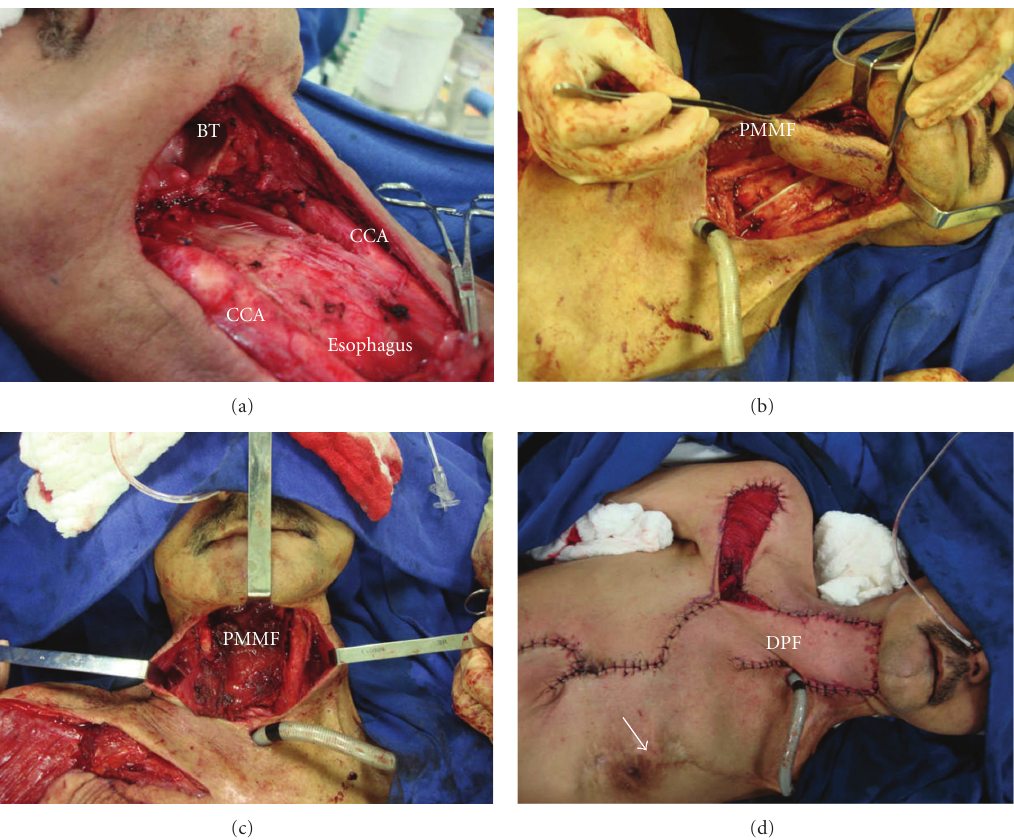
Figure 1: (a) Defect resulting from a circular laryngopharyngectomy for a stage IV squamous cell carcinoma in a patient previously treated with surgery and radiation therapy from an oropharynx cancer (BT: base of tongue; CCA: common carotid artery). (b) Pectoralis major myocutaneous flap (PMMF) being sutured over the pre-vertebral fascia, creating the neo-hypopharynx. (c) PMMF in place after the end of the sutures. (d) Deltopectoral flap (DF) rebuilding the neck skin and covering the PMMF (the arrow shows the chest scar from the contralateral PMMF used in the reconstruction of the defect secondary to the surgical treatment of the first primary tumor of the